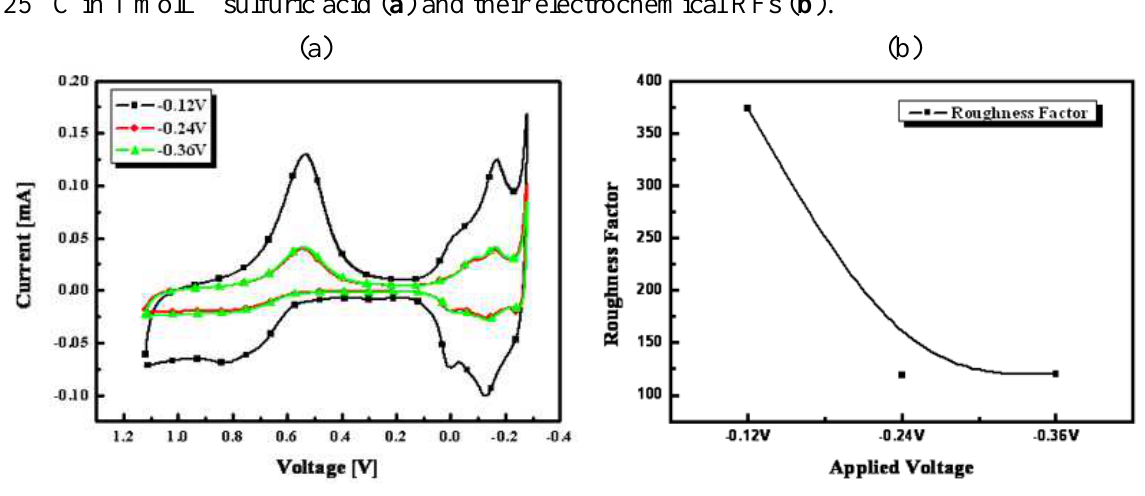
Figure 5. Cyclic voltammograms of nanoporous Pt electroplated between -0.12 and -0.36 mV of applied voltages at the conditions of fixed charge of 35 mC/mm 2 and temperature